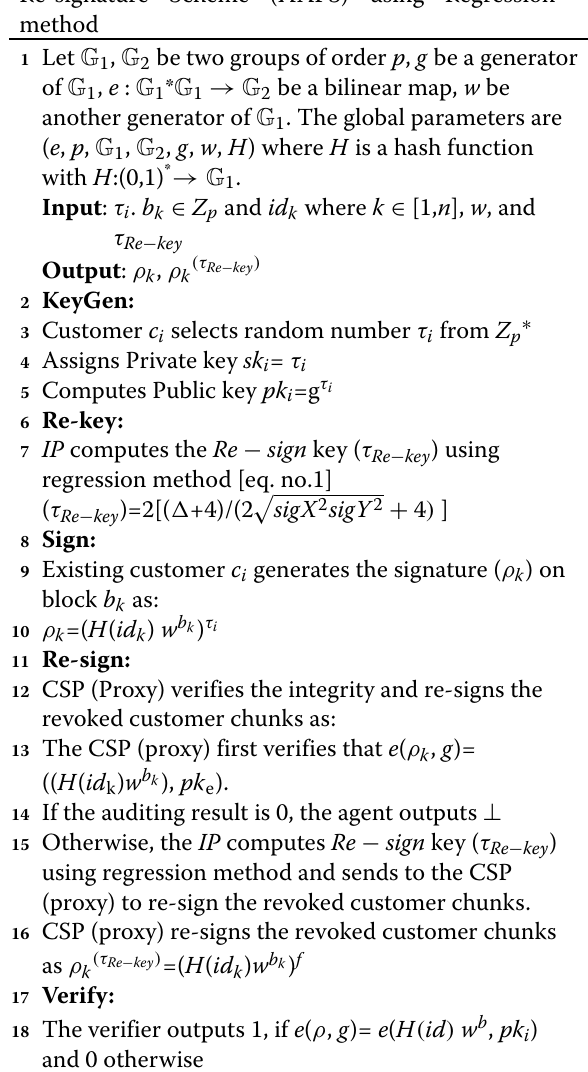
Algorithm 1: Homomorphic Authenticable Proxy Re-signature Scheme (HAPS) using